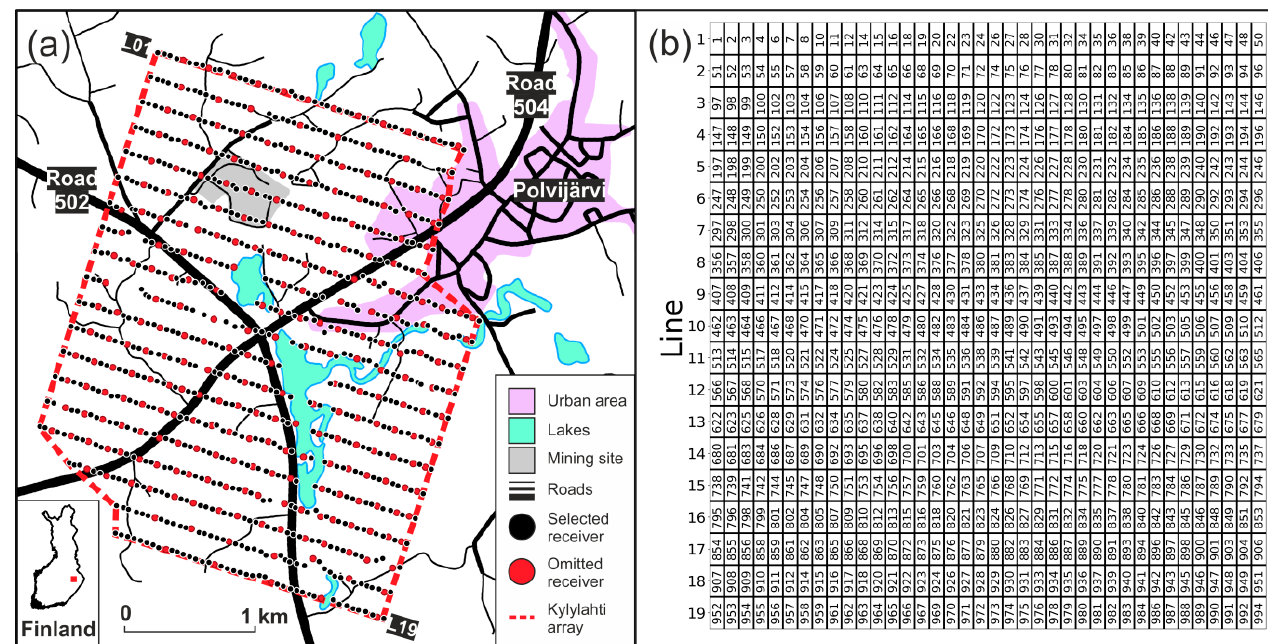
Figure 1. ( a ) Map of the study region. Red and black dots are the receivers forming the Kylylahti array. To maintain an equal number of receiver stations per seismic line, some of the receivers (depicted in red) are skipped and do not contribute to the computation of attribute maps. The red dashed line represents the contour enclosing all the receiver lines of the array (labeled as L01–L19). The inset shows an outline map of Finland and the location of the plotted region (red square). ( b ) Matrix representation of the subsampled Kylylahti array. Each of the selected receiver stations is mapped to the corresponding cell number (hereafter referred to as a receiver identification number). The rectangular shape of cell tiles is caused by duplication of each row (receiver line). It is needed to match the number of columns (receivers) and preserve the aspect ratio of a